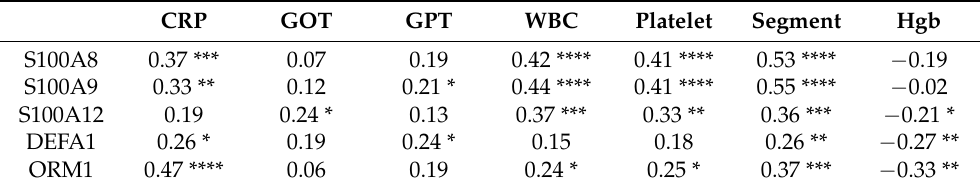
Table 4. Correlation of the conventional laboratory items and five selected candidate proteins. CRP